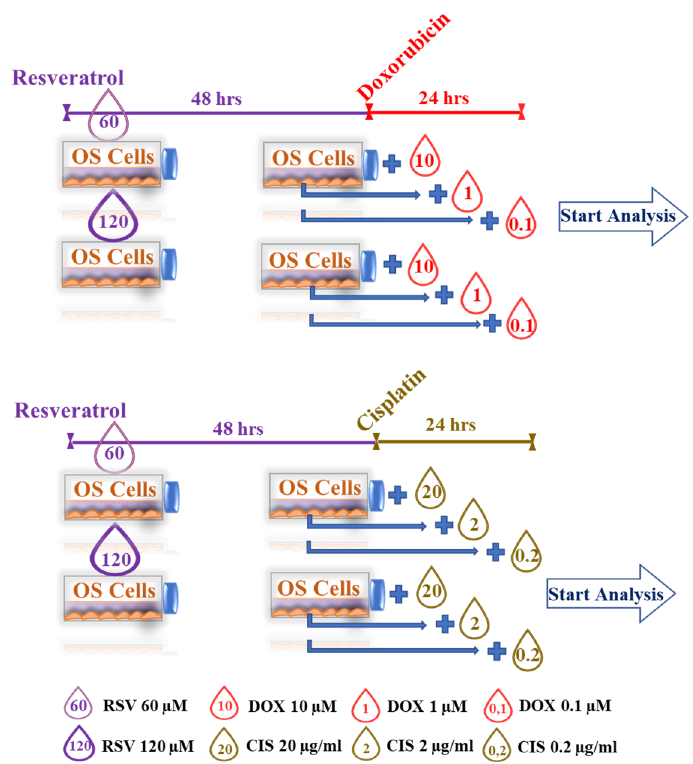
Figure 9. Set ‐ up of RSV–DOX and RSV–CIS cotreatments. Figure 9. Set-up of RSV–DOX and RSV–CIS